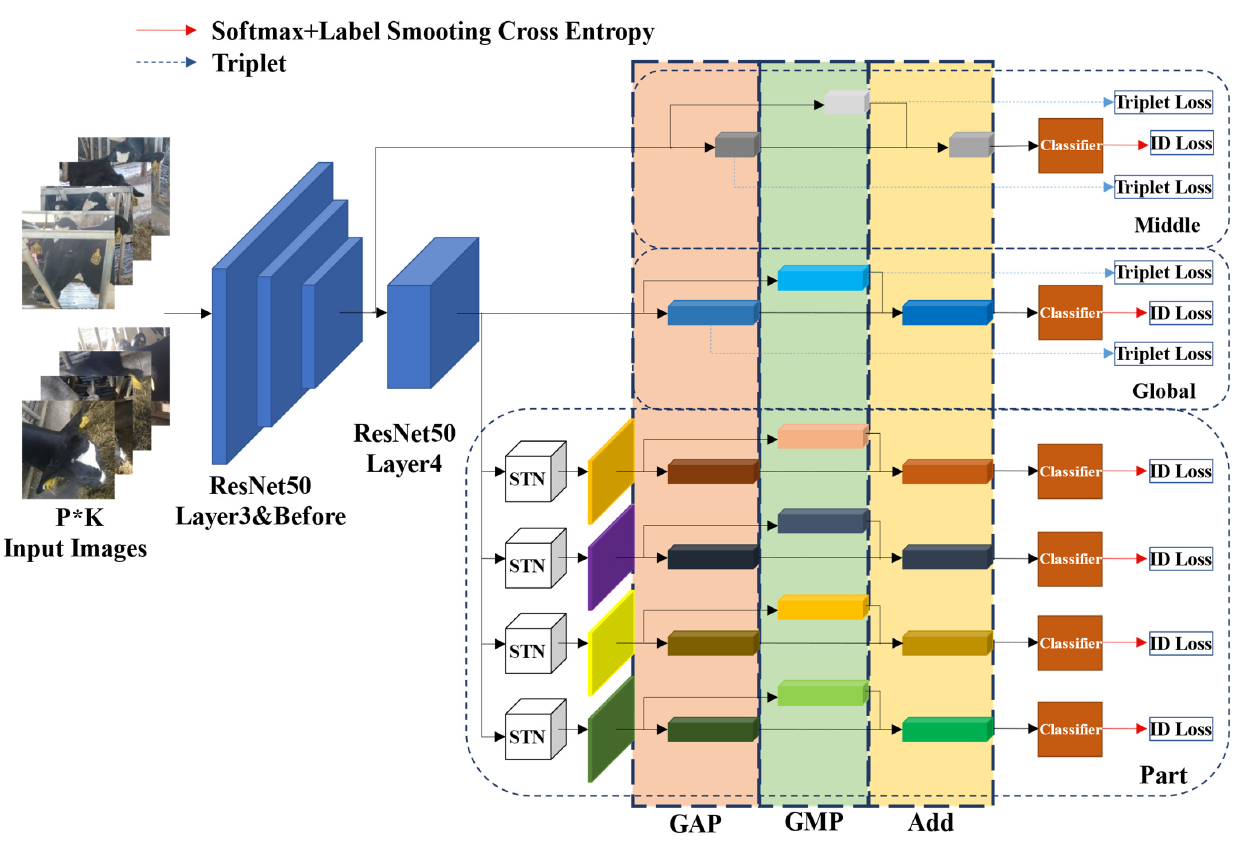
Figure 6. Architecture of the proposed GPN-ST model. The GPN-ST model is improved in the Part branch used to extract the local regions via four STN modules